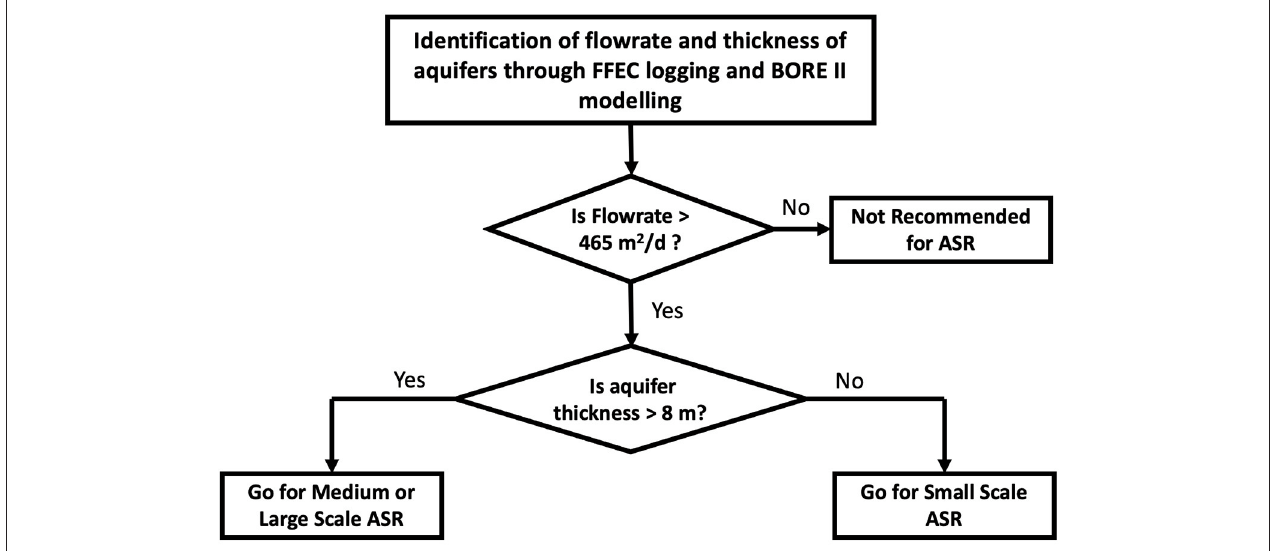
FIGURE 2 | Flowchart for the feasibility of the aquifer for aquifer storage and recovery.